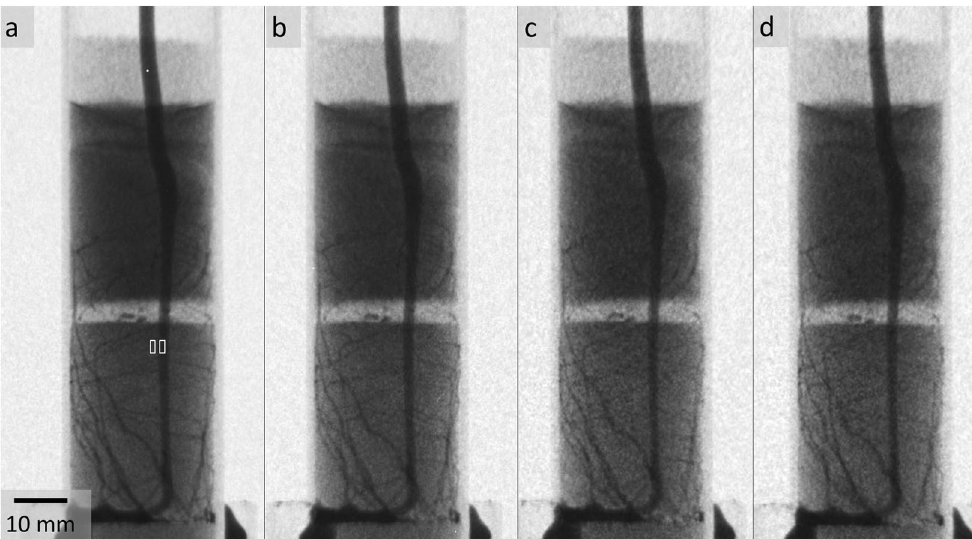
Figure 2. Analogous radiographic projections captured while sample was rotating in four different ultra-fast neutron tomographies constituting a tomographic test series. ( a ) 60 s – tomography: t exp = 0.2 s; ( b ) 30 s –